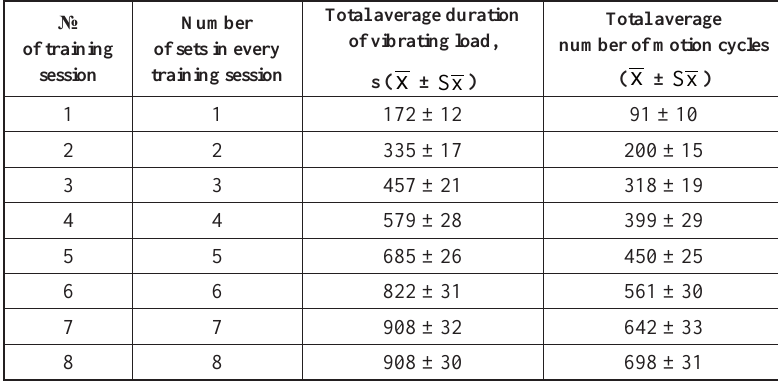
Table 1. The protocol of adjacent training sessions with increasing vibrating loadings (rest intervals 3—5